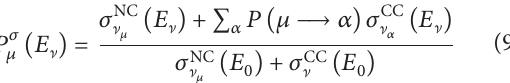
Figure 11: Event rates of oscillated ] 𝑒 -CC events as function of cos Θ , which is proportional to the baseline. (a) Comparison of event rates for both hierarchy hypotheses (same color code as in earlier figures). (b) Event rate differences from left